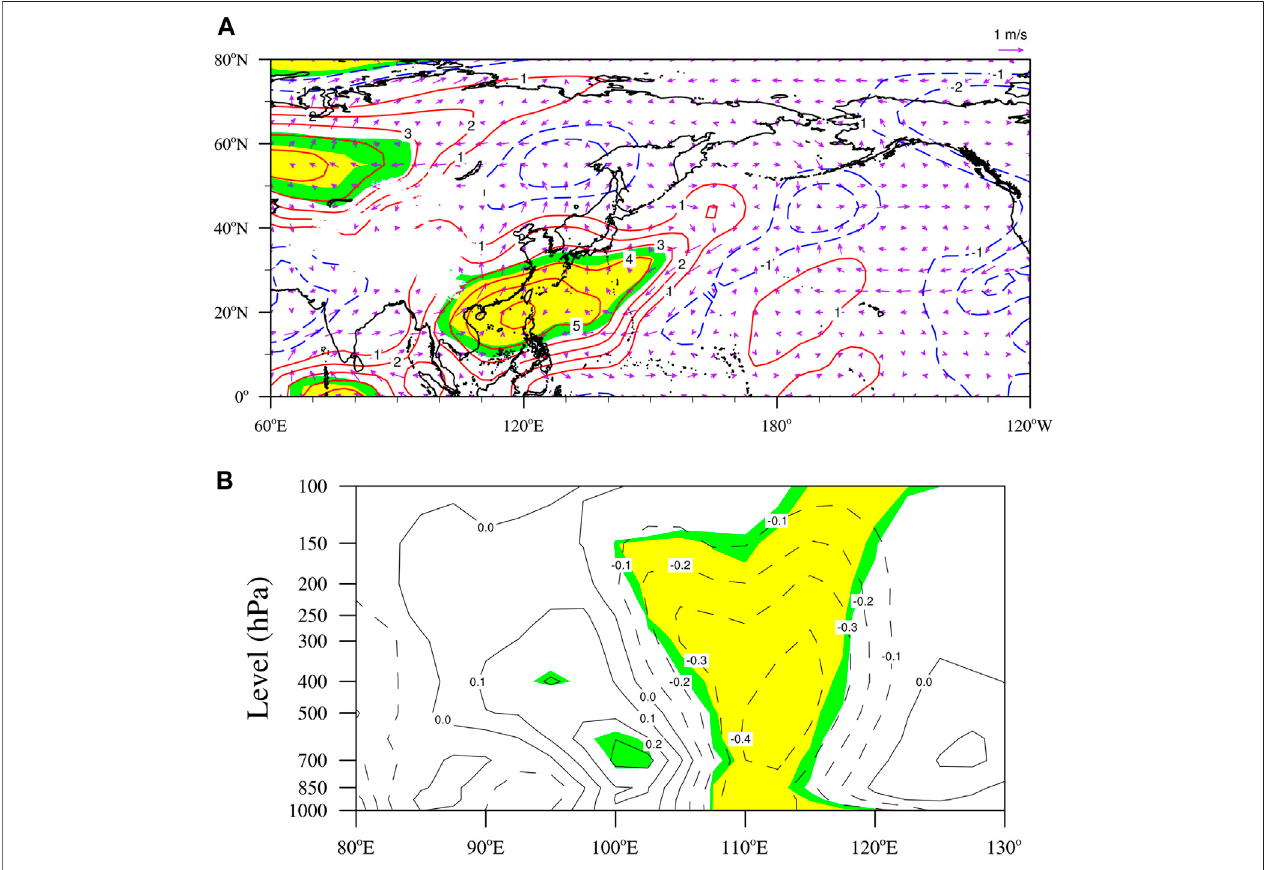
FIGURE 9 | Regressed September (A) velocity potential (unit: 10 5 m 2 s − 1 ; contours) and divergent winds (unit: m s − 1 ; vectors) at 850 hPa and (B) longitude – pressure section of 20 ° – 40 ° N mean vertical velocity (unit: 0.01 Pa · s − 1 ; contours) against the APOI for 1961 – 2020. Yellow (green) shading indicates the 95% (90%) con fi dence level. Topography with elevations higher than 1,500 m has been masked in (A)